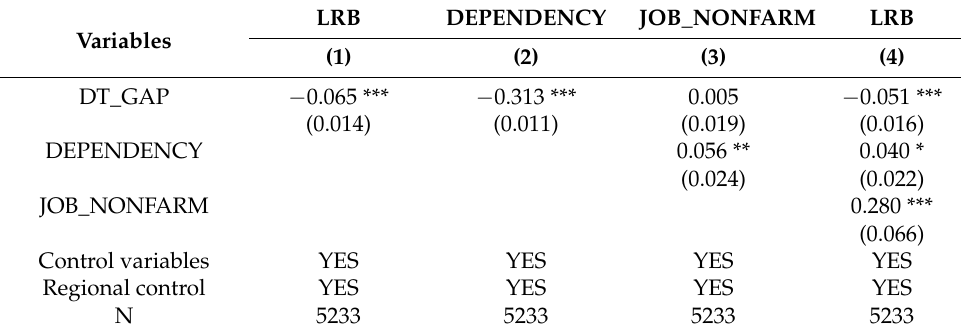
Table 7. Results of CMM model of DT_GAP’s impact on